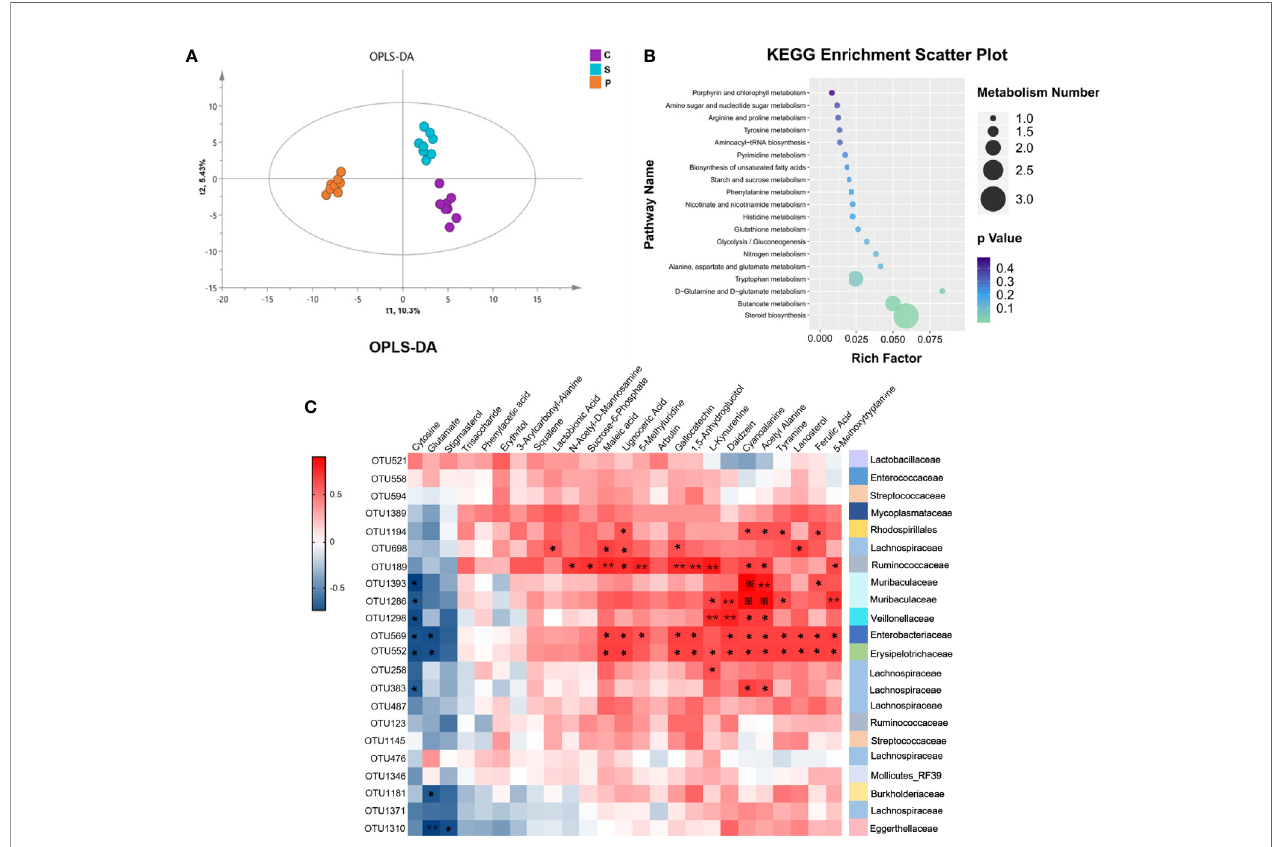
FIGURE 6 | Fecal metabolism characteristics of PSD and its related KEGG enrichment pathways. (A) Orthogonal Partial Least Squares Discrimination Analysis (OPLS-DA) showed fecal metabolism of PSD was signi fi cantly different from that in control and stroke (n = 8 per group). (B) The 25 differential metabolites for PSD rats compared with control and stroke rats were enriched in 19 KEGG pathways. (C) Associations of gut microbial OTUs with fecal metabolites. Heat map of the spearman ’ s rank correlation coef fi cient of 22 discriminative OTUs and 25 differential metabolites for PSD. Red squares indicate positive associations between these microbial OTUs and metabolites, blue squares indicate negative associations (n = 8 per group). 54.55% (12/22 OTUs) of altered bacterial OTUs showing signi fi cant correlations with a range of differential metabolites (p < 0.05) and correlation coef fi cient were ≥ 0.6 or ≤ − 0.6, tested by spearman correlation. The statistical signi fi cance was denoted on the squares (*p < 0.05; **p < 0.01; ※ p <